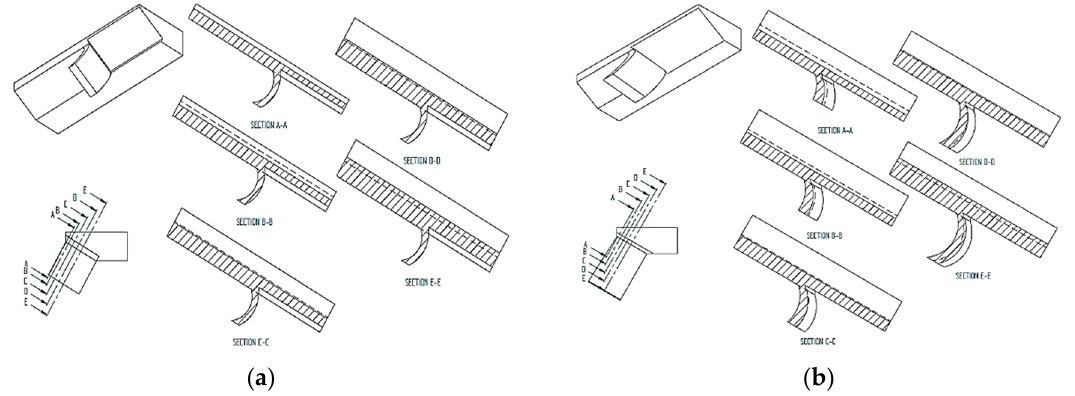
Figure 9. Cross-sections of a chip root at oblique cutting at the angle ( a ) λ s = 0°, ( b ) λ s > 0°.